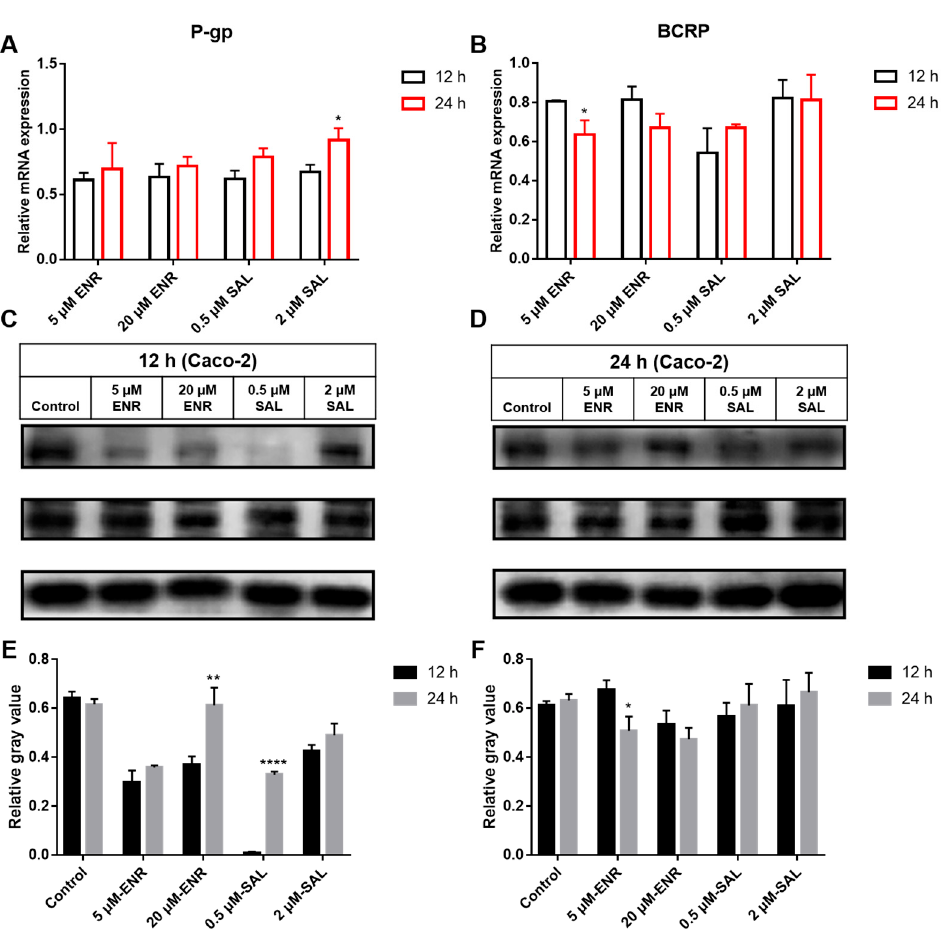
Figure 7. Effects of ENR and SAL on gene and protein expression of P-gp and BCRP in Caco-2 cells. ( A , B ) are the mRNA expression levels of P-gp and BCRP, respectively. ( C , D ) are the protein expression levels of P-gp and BCRP, respectively. ( E , F ) are gray value levels of P-gp ( C ) and BCRP ( D ), respectively. * indicates the difference compared with the same concentration of drug incubated for 12 h. * means p < 0.05; ** means p < 0.01; **** means p < 0.001.